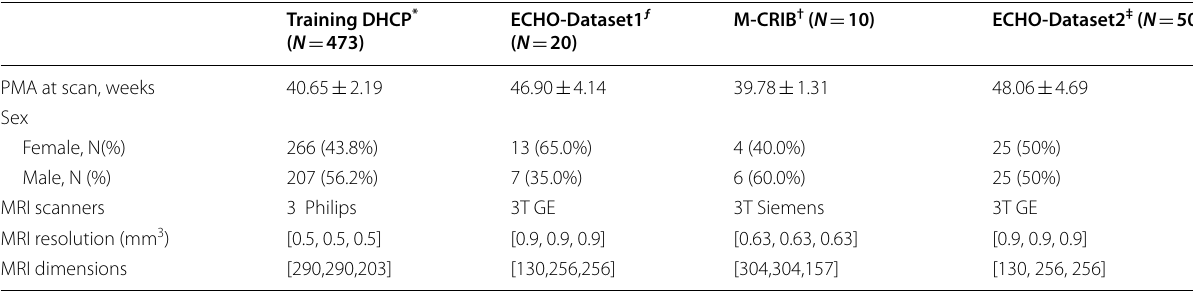
For quantitative variables, data are presented as mean standard deviation unless otherwise noted. PMA: postmenstrual age. * The large training DHCP dataset with ± corresponding dHCP labels was used to pre-train the model with sufficient data. ƒ The ECHO-Dataset1 dataset was used to test the model’s performance as an internal source. † The M-CRIB dataset was used as an external test dataset to further test the reliability of our proposed deep learning framework. ‡ The proof-of-concept ECHO- Dataset2 was used to test the association between brain morphometric measures at birth and corresponding CBCL measures at age